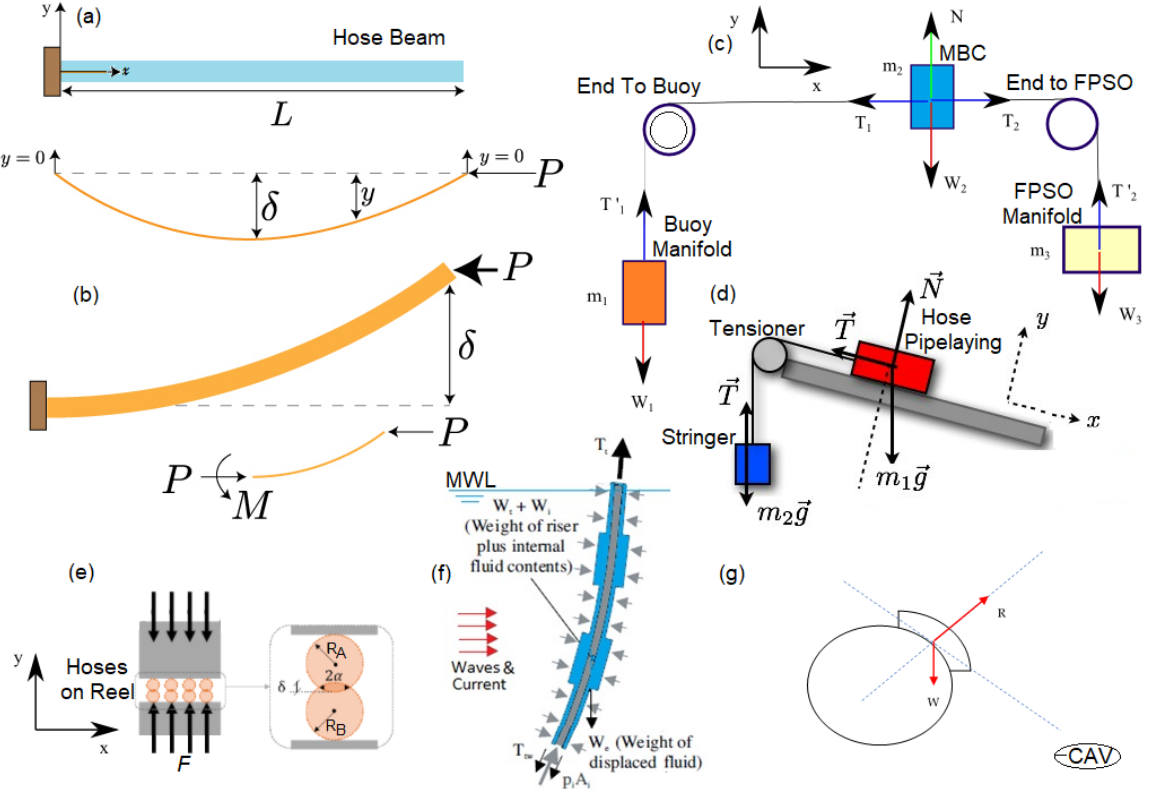
Figure 30. Free-Body Diagram (FBD) for different load scenarios of marine hose applications showing ( a ) hose beam simply supported, ( b ) hose beam under tension and torsion, ( c ) hose connected between buoy and FPSO, ( d ) hose during pipelaying, ( e ) hoses on a reel from section view, ( f ) hose segment showing fluid content and waves, and ( g ) Crush load for a section of the hose on with valve; Where R (Crush load of hose riser) = Wcos θ , W = (Self weight of hose riser + internal fluid weight), θ = Angle between weight (W) and reaction vector respectively, m 1 = mass of hose riser, T = Tension force of hose, P = force acting in direction towards hose end, F = force acting on the side of the hoses on a reel, MWL = mean water level, M = the moment and δ = the displacement.